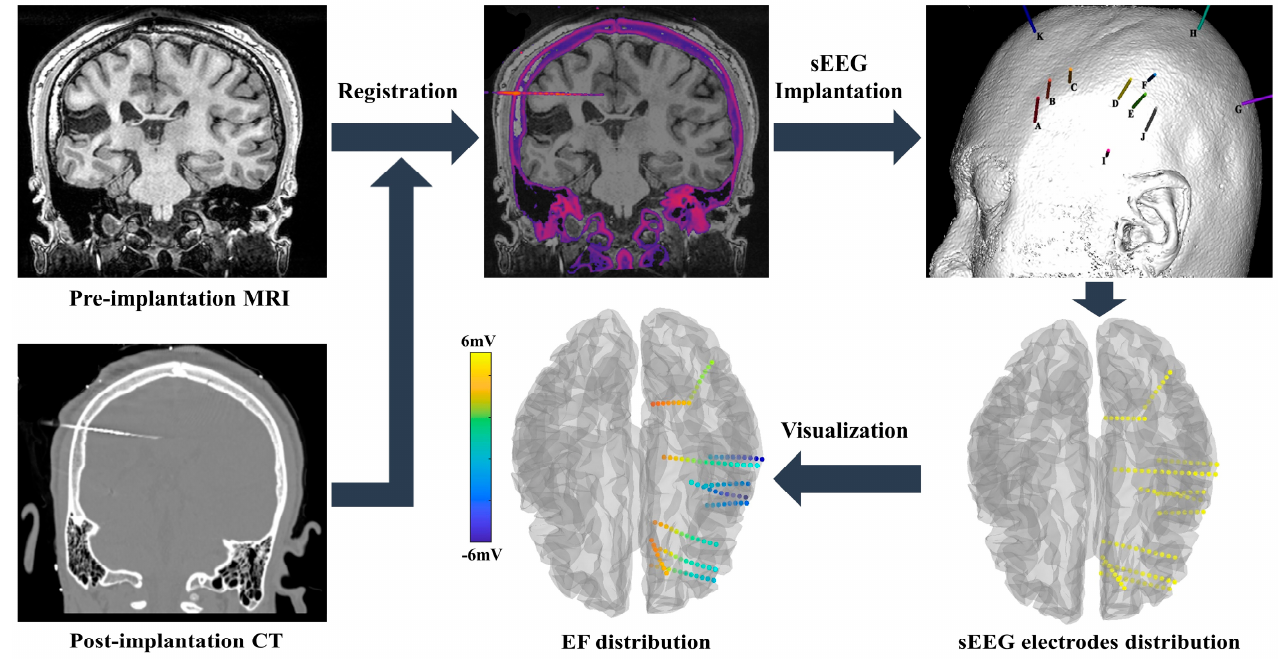
Figure 3. The analysis procedure of sEEG electrode positioning and Electric field model- ing.